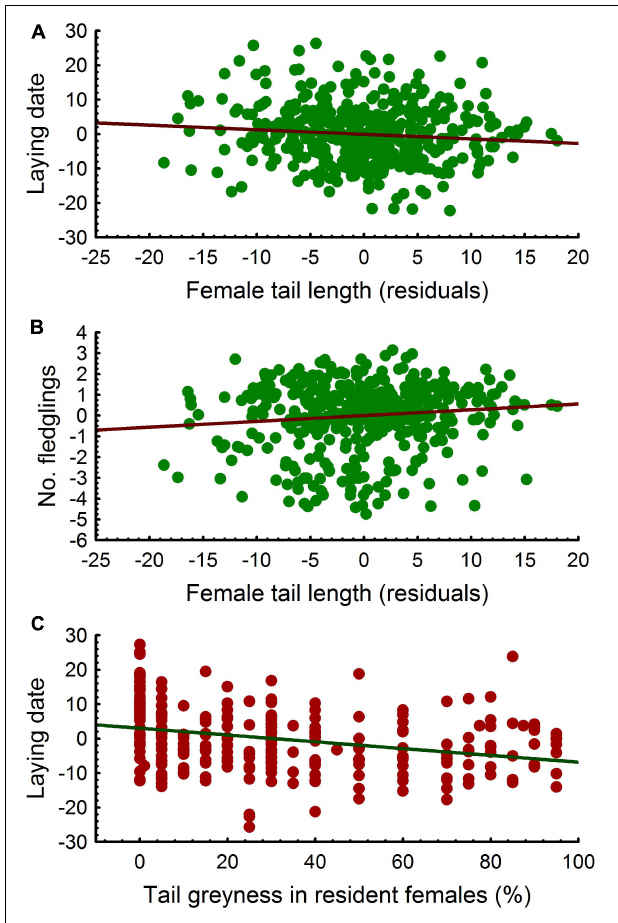
FIGURE 6 | Linear relationship between laying date (residuals) and tail length (A) , number of fledglings and tail length (B) and laying date (residuals) and tail grayness (C) in female common kestrels.